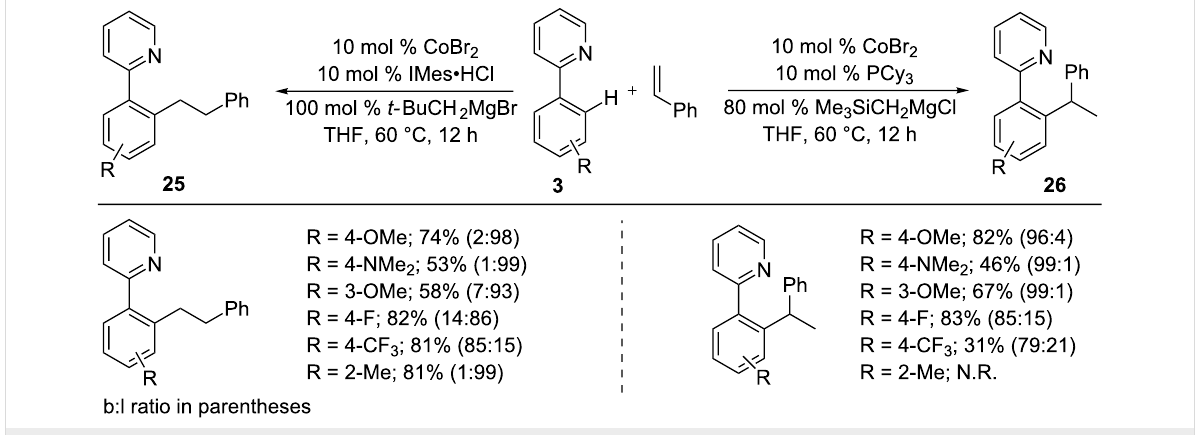
Scheme 17: Co-catalyzed switchable hydroarylation of styrenes with 2-aryl